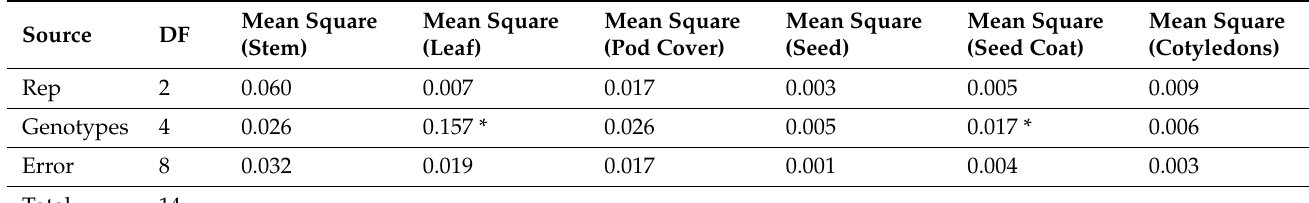
Table 7. Analysis of Variance of Total ODAP content (%) of different L. sativus accessions at ma- ture stage.